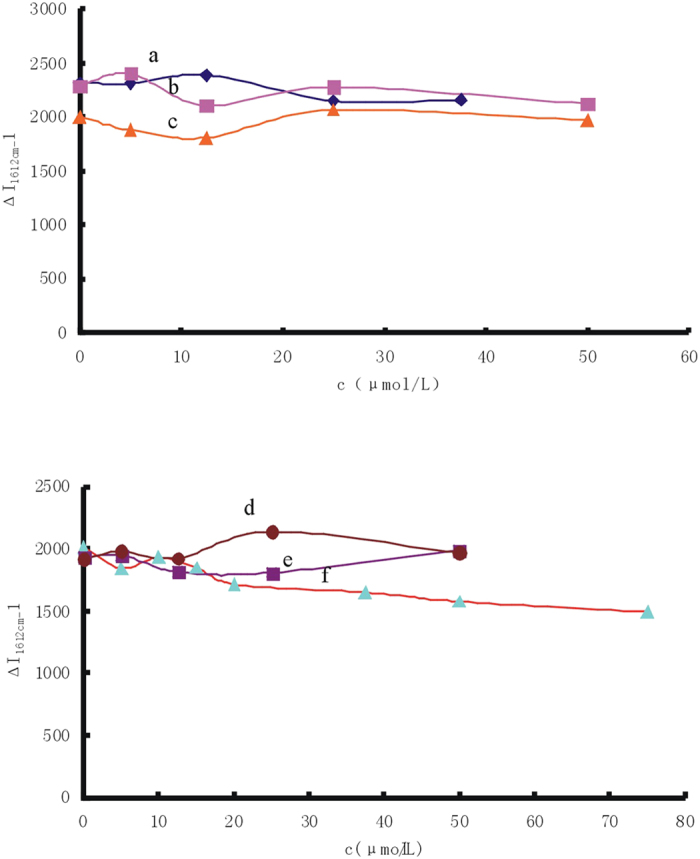
Influence of reducing agent concentration(a) 1 × 10−4mol/L AgNR-75 mmol/L HAc-75 nmol/L Hg(II) -20 mmol/LNaCl -1.5 × 10−7mol/L VBB-NaBH4; (b) 1 × 10−4mol/L AgNR -75 mmol/L HAc-75 nmol/L Hg(II) -20 mmol/LNaCl -1.5 × 10−7mol/L VBB-Vc; (c) 1 × 10−4mol/L AgNR -75 mmol/L HAc-75 nmol/L Hg(II) -20 mmol/LNaCl -1.5 × 10−7mol/L VBB- hydrazine hydrate; (d) 1 × 10−4mol/L AgNR -75 mmol/L HAc- 75 nmol/L Hg(II) -20 mmol/LNaCl -1.5 × 10−7mol/L VBB - hydroxylamine hydrochloride; (e) 1 × 10−4mol/L AgNR -75 mmol/L HAc-75 nmol/L Hg(II) -20 mmol/LNaCl -1.5 × 10−7mol/L VBB-H2O2; (f) 1 × 10−4mol/L AgNR -75 mmol/L HAc-75 nmol/L Hg(II) -20 mmol/LNaCl -1.5 × 10−7mol/L VBB-Na2SO3.